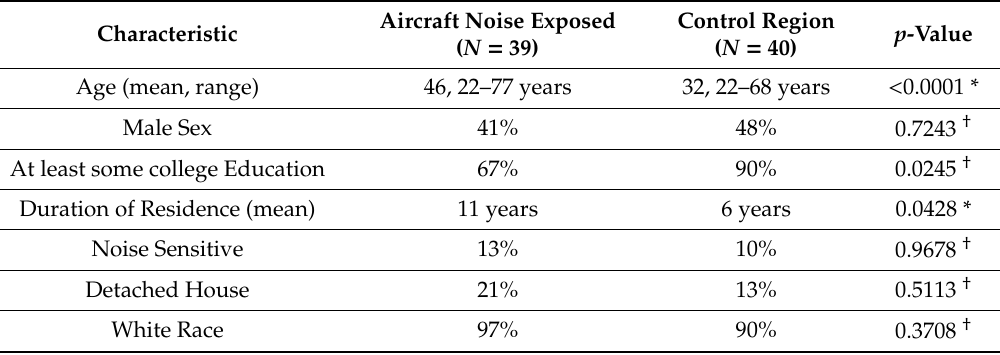
Table 2. Socio-demographic characteristics of participants in the pilot